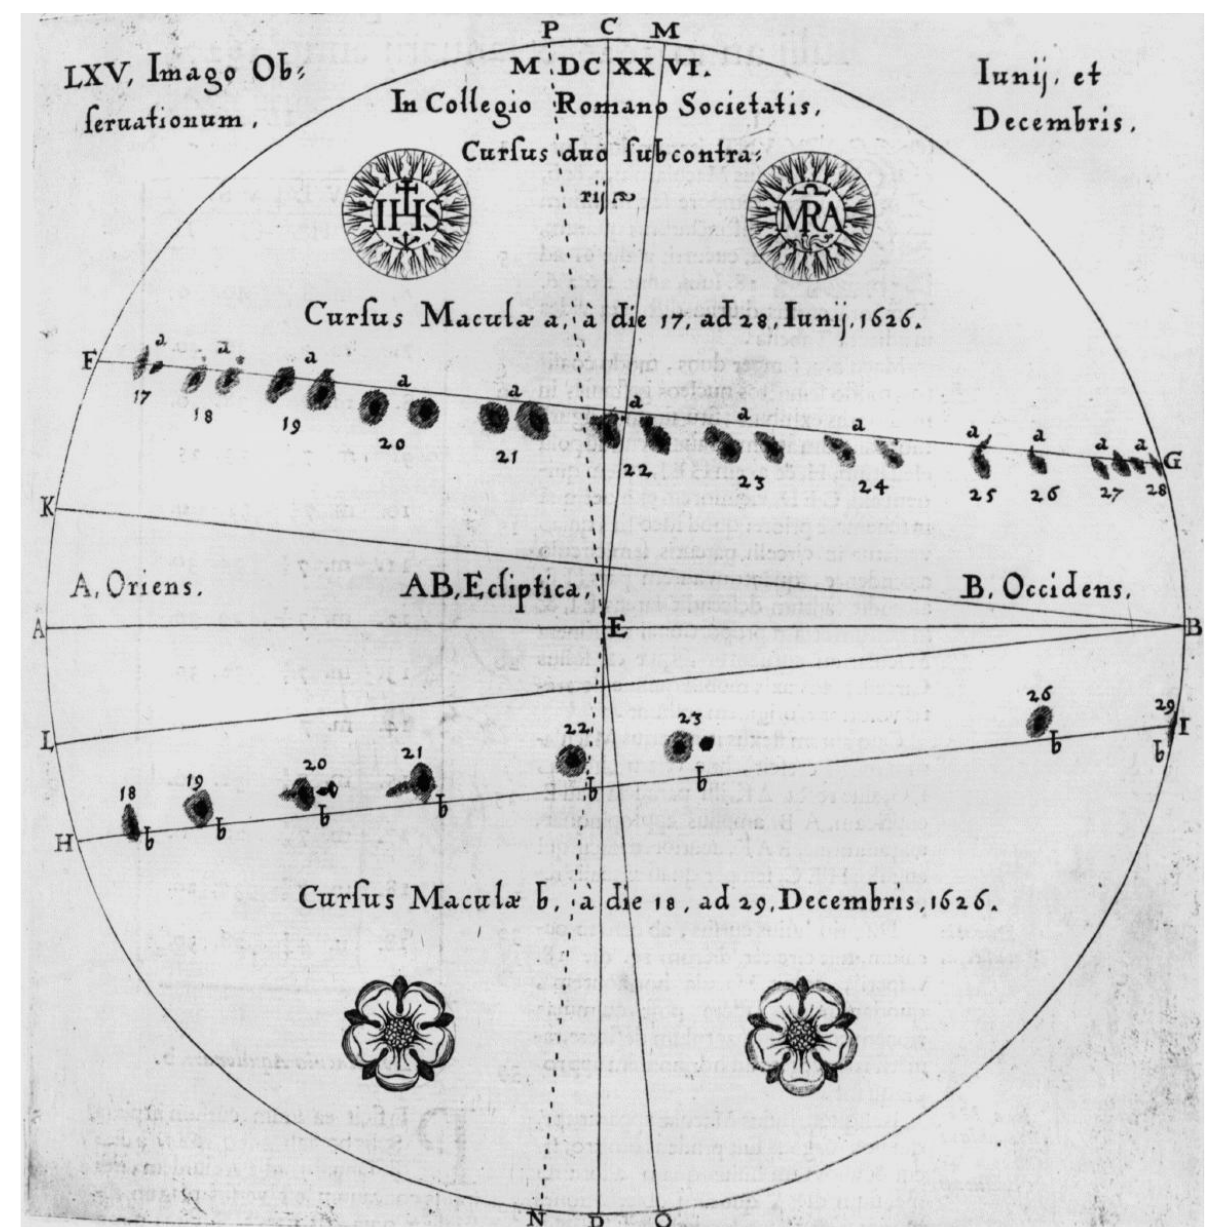
Fig. 4. The daily progression of sunspots across the solar disk during the interval AD 1626 June 17–28 (Scheiner, 1630). This figure indicates that the unaided-eye Chinese sunspot observation on AD 1626 June 29 (see Table 1) is apparently spurious because the pair of sunspots in the northern half of the solar disk would have already passed just beyond the west limb of the Sun by that time. However, this same pair of sunspots crossed the central meridian on June 22 and is therefore probably associated with the Korean auroral observation on June 24 (see Table